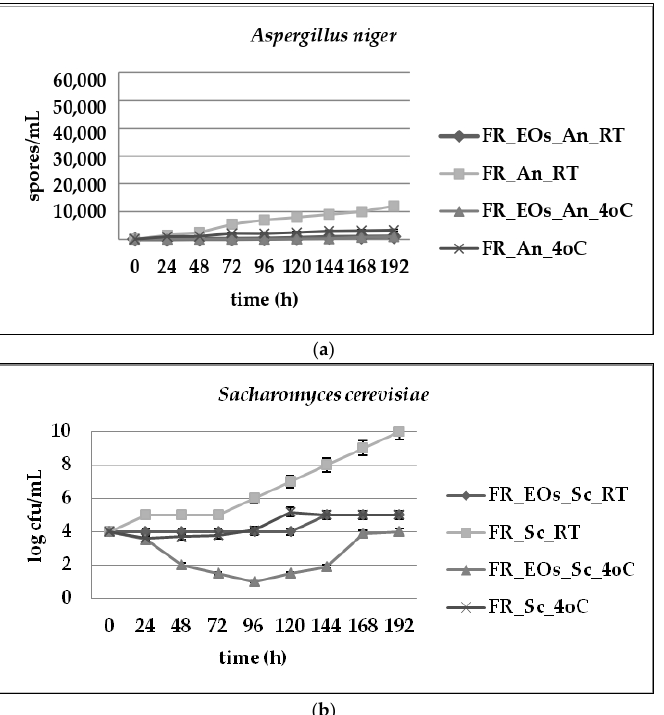
Figure 3. Counts of ( a ) A. niger , ( b ) S. cerevisiae , in spiked samples of fruit juice (FR) supplemented with P. lentiscus and F. margarita EOs during storage at room temperature (RT) and at 4 ◦ C. Spiked samples of fruit juice with no EOs served as controls.